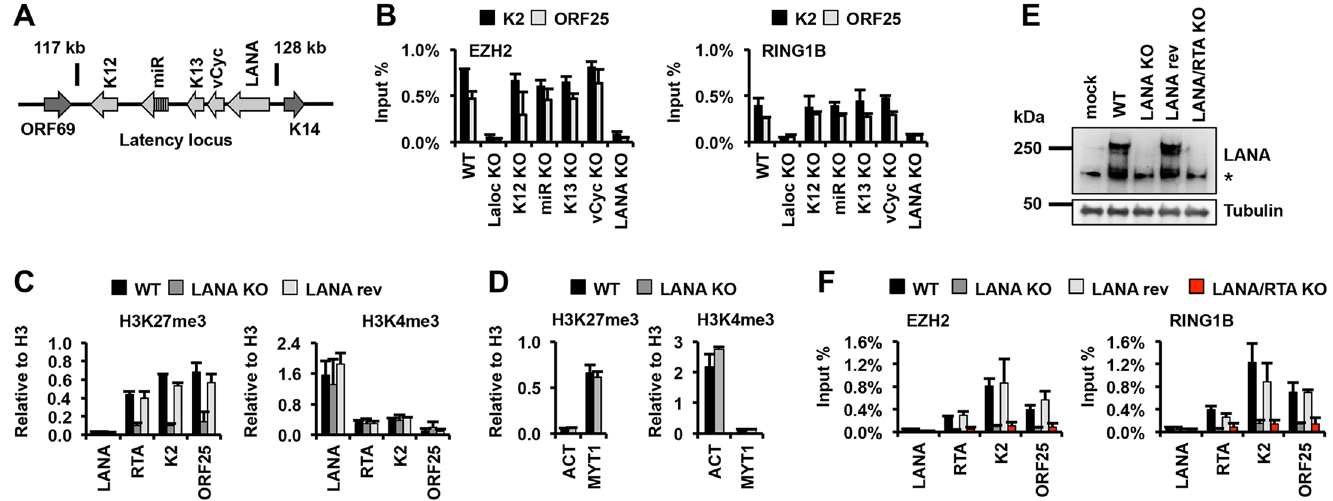
Fig 1. LANA is required for the recruitment of Polycomb proteins to lytic promoters during de novo infection. (A) Schematic of the KSHV latency locus encoding latent genes. (B) ChIP assays testing the recruitment of PRC2 factor EZH2 and PRC1 factor RING1B onto viral lytic promoters in SLK cells 72 hours after infection with WT or the indicated KSHV mutants. (C and D) ChIP assays for the repressive (H3K27me3) and activating (H3K4me3) histone marks on viral and cellular promoters at 72 hpi. The LANA and actin (ACT) promoters devoid of H3K27me3 and the PRC2-regulated MYT1 promoter served as controls. (E) Immunoblots showing LANA protein levels in mock and KSHV-infected SLK cells at 72 hpi. * Non-specific. (F) ChIP assays for EZH2 and RING1B associations with viral promoters at 72